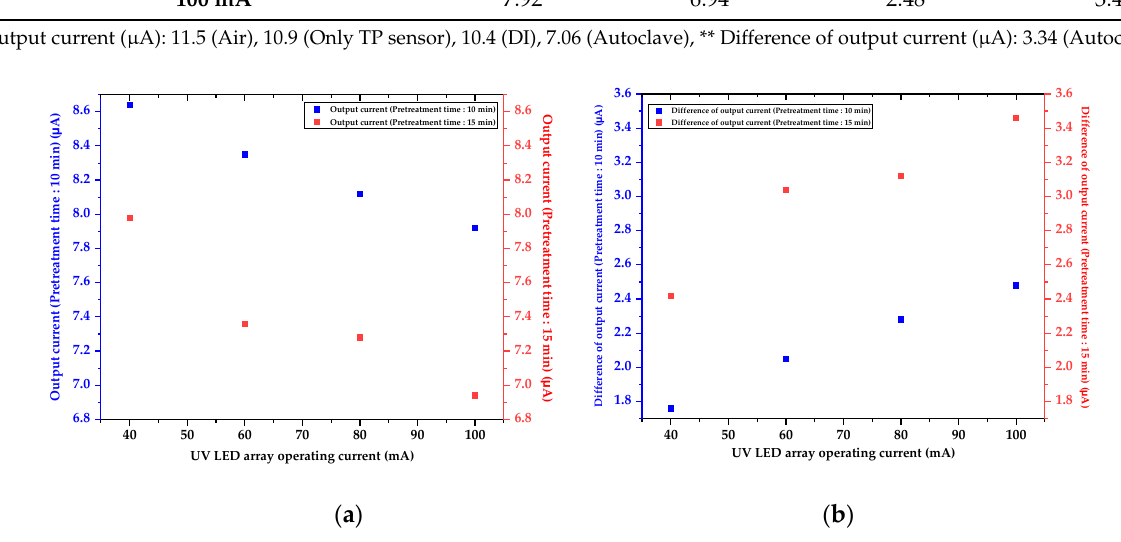
Table 3. Comparison of the autoclave and the miniaturized TP analysis system (pretreatment conditions: 100 mA UV LED array operating current and 15 min pretreatment time). The difference of the output current was calculated by differencing the output current between the DI (without phosphorus) and the analytes (with phosphorus).